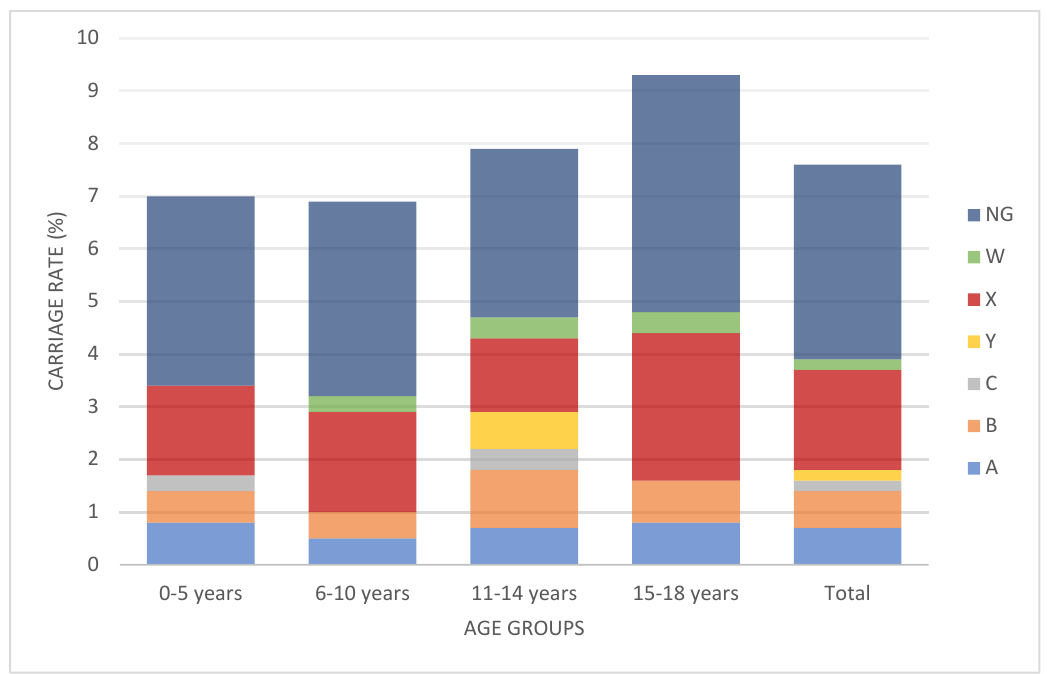
Figure 2. Percentage of meningococcal serogroup carriage (including non-groupable isolates) according to age group. There were no statistical differences between the age groups ( p > 0.05). (NG: non-groupable).